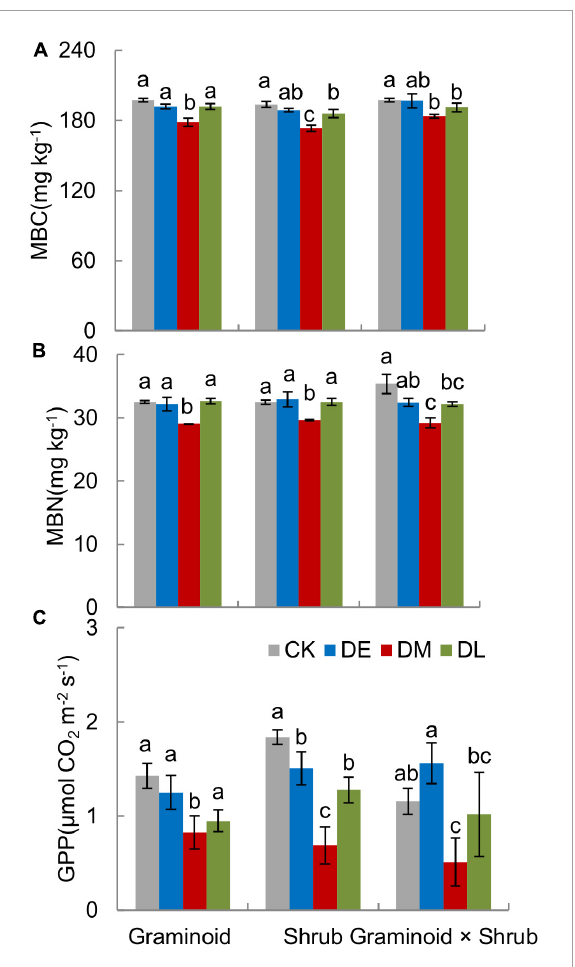
FIGURE5 Growing season mean value of soil microbial biomass ( MBC, A ), microbial biomass nitrogen ( MBN, B) , and gross primary productivity ( GPP, C) in three PFTs under different drought timing treatments in 2017. Data are mean ± 1SE. Different letters indicate significant differences ( P ≤ 0.05) between